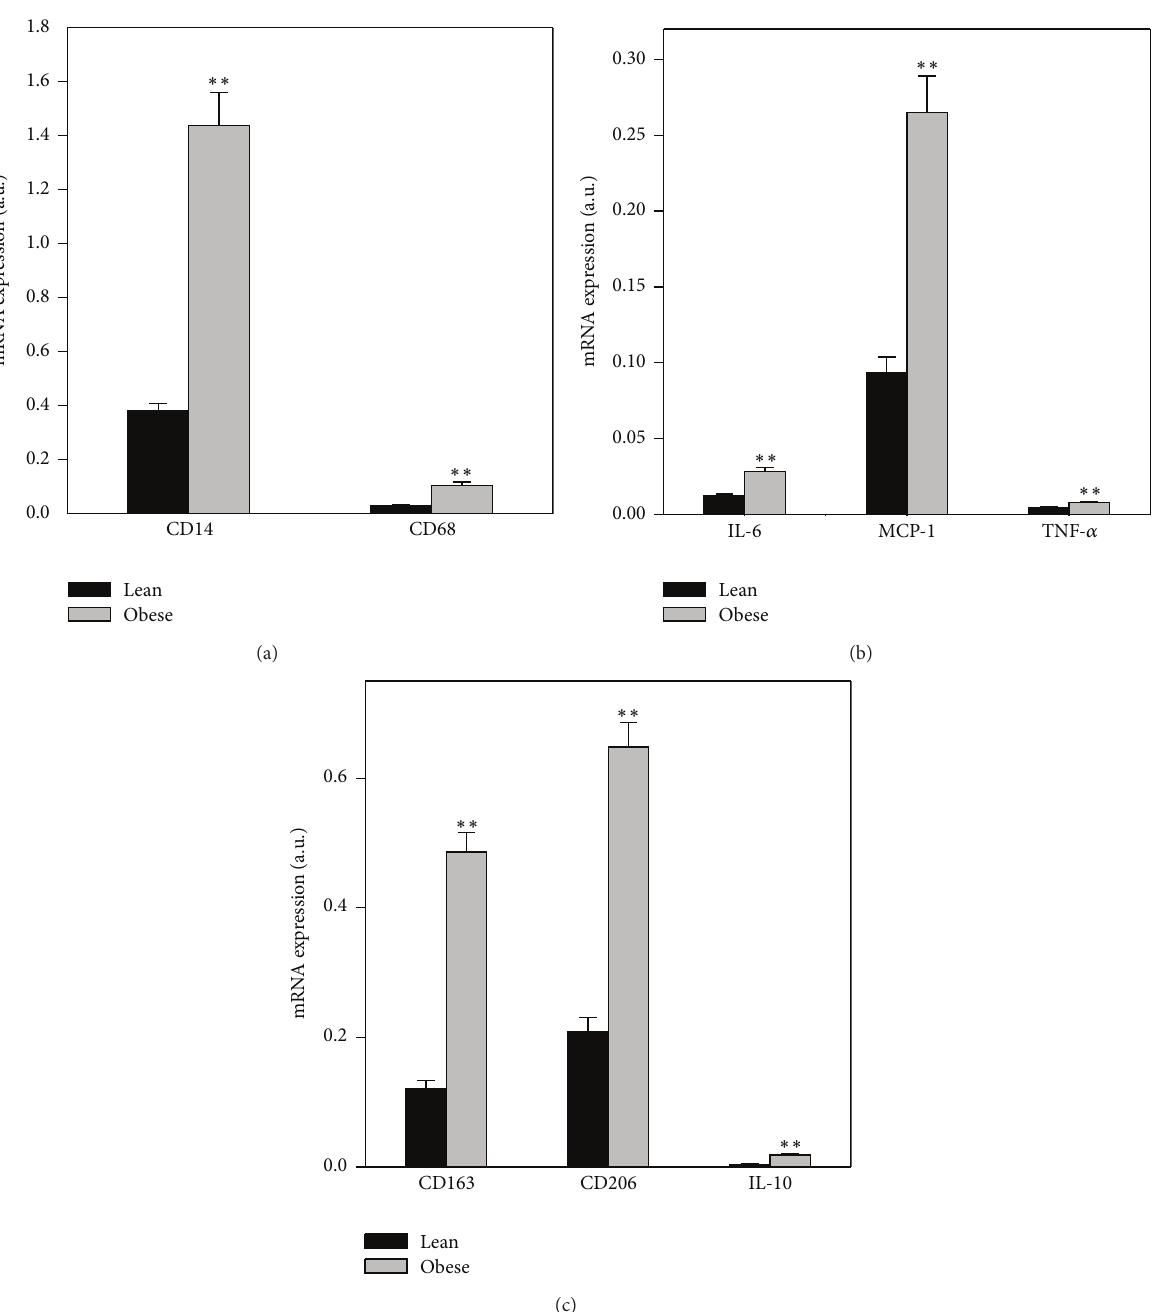
Figure 1: Difference in macrophage markers in AT between lean and obese subjects. Subcutaneous abdominal adipose tissue samples from lean ( 𝑛 = 35 ) and obese ( 𝑛 = 57 ) subjects. Gene-expression levels of different macrophage markers measured by real time PCR. (a) The general macrophage markers CD14 and CD68 in ATMs from lean and obese subjects. (b) Proinflammatory markers, IL-6, MCP-1, and TNF- 𝛼 , in ATMs from lean and obese subjects. (c) Anti-inflammatory markers CD163, CD206, and IL-10 in ATMs from lean and obese subjects. Wilcoxon Mann-Whitney rank sum test. ∗∗ 𝑃 < 0.001 .